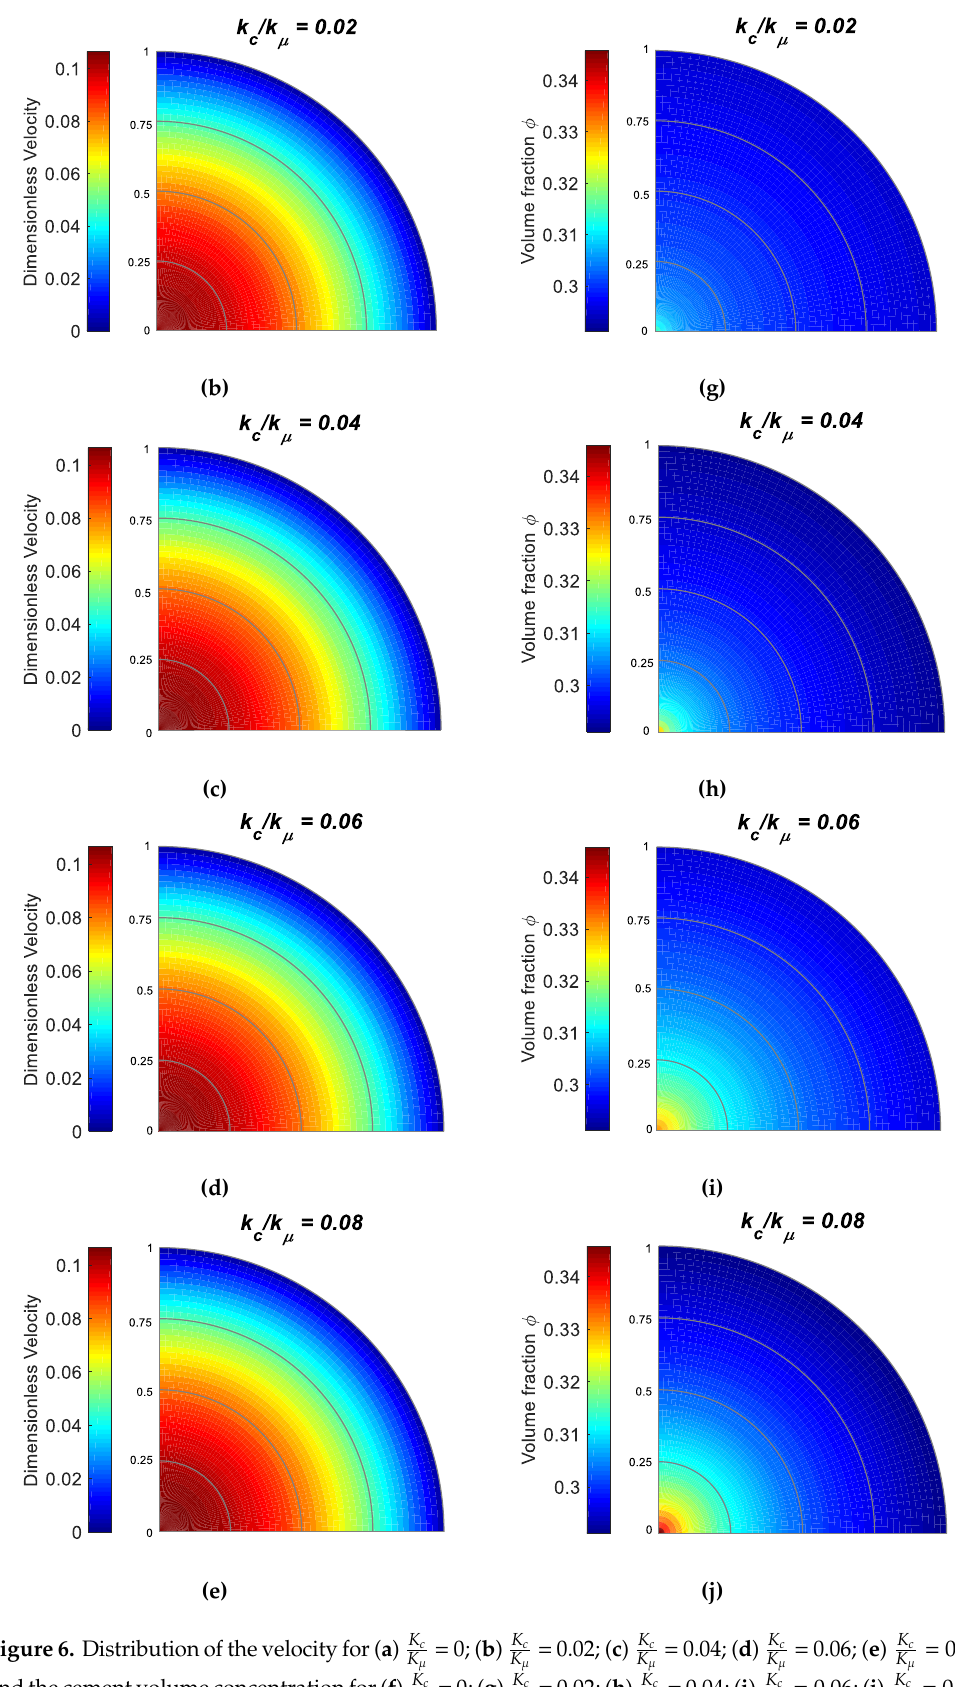
Figure 6. Distribution of the velocity for ( a ) K c and the cement volume concentration for ( f ) K c